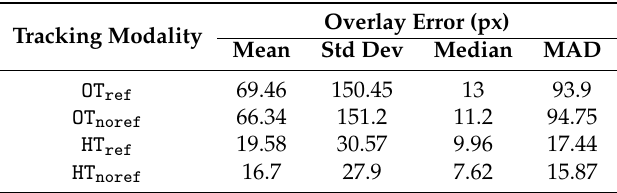
Table 2. Results of the overlay accuracy analysis in pixels (o S ) comprising sequence of camera frames with tracking failures ( < 30 consecutive